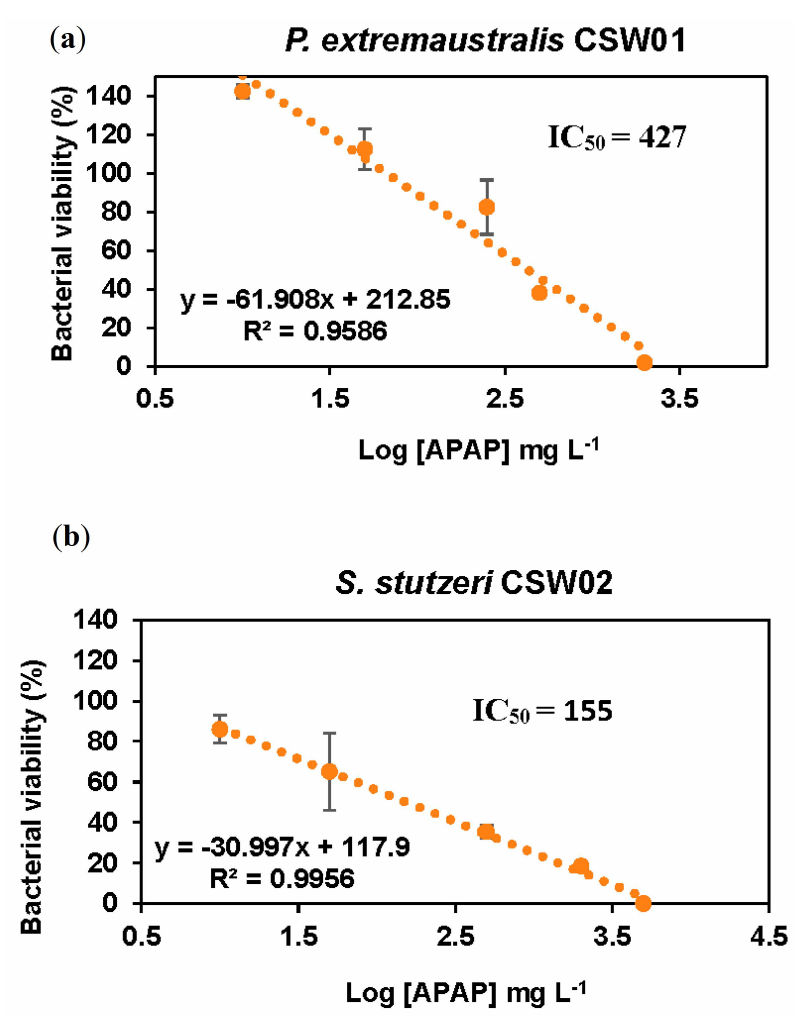
Figure 4. Graphical representation of the best fitting linear curves for bacterial viability as a function of the logarithm of APAP concentration for P. extremaustralis CSW01 ( a ) and S. stutzeri CSW02 ( b ).